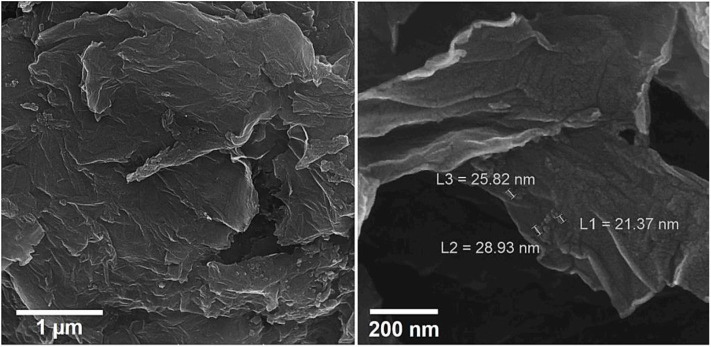
SEM images of Gr/Co3O4 nanocomposite.